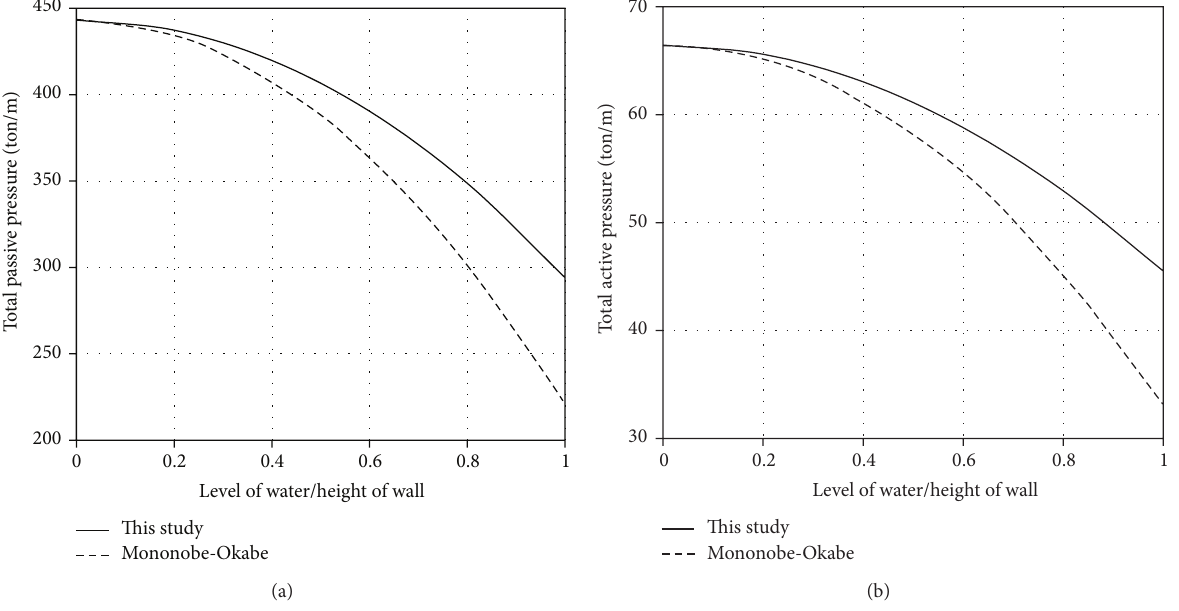
Figure 11: Effects of water table on total lateral earth pressure compared to